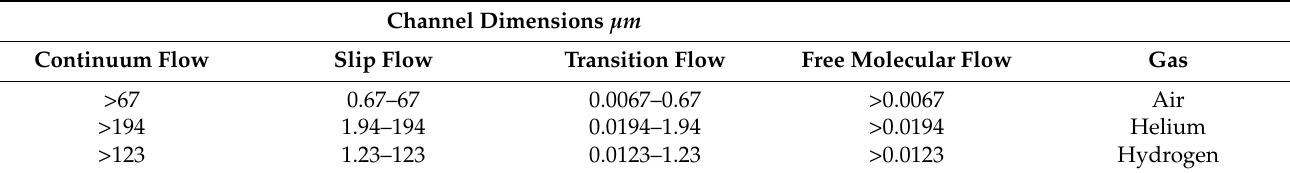
Table 3. Channel dimensions for types of gas flow at atmospheric pressure